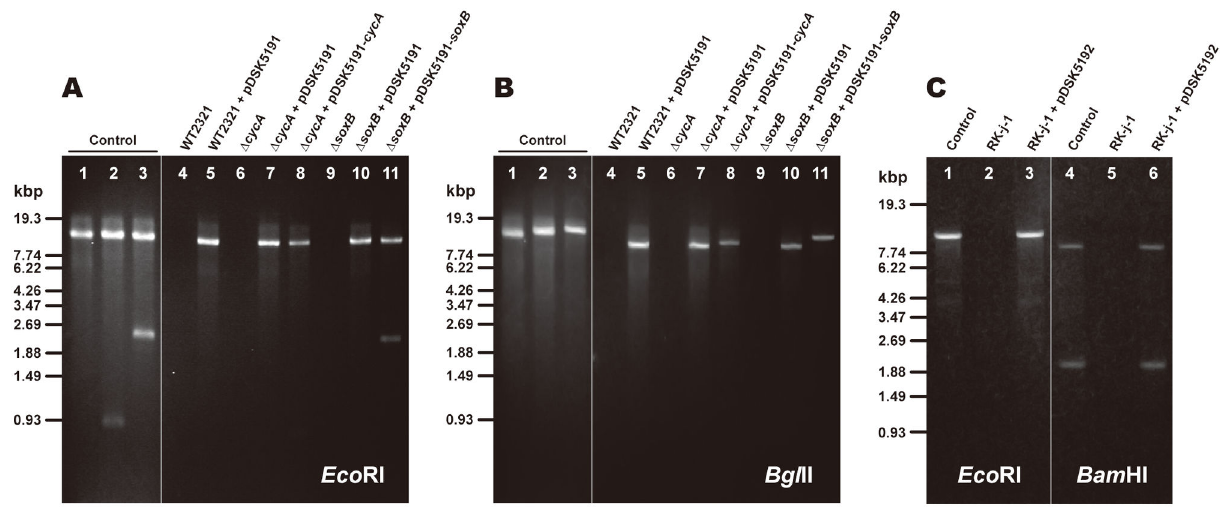
Figure 2. Restriction enzyme mappings of the plasmids in the C. tepidum and C. limnaeum transconjugants. (A, B) Physical maps of the plasmids from the C. tepidum transconjugants. The maps were constructed with restriction enzymes Eco RI (A) and Bgl II (B). The restriction fragments were separated by agarose gel (1%) electrophoresis. The control plasmids pDSK5191 (lane 1), pDSK5191- cycA (lane 2), and pDSK5191- soxB (lane 3) were obtained from the donor S17-1 cultures. Lanes 4-11 are the plasmid samples of the C. tepidum cultures. The genotype of C. tepidum is indicated above each lane. The bars and numbers at the left side of the panel indicate mobility and size of the Sty I digests of the λ-phage DNA. (C) Physical maps of the plasmids from C. limnaeum transconjugants. The maps were constructed with restriction enzymes Eco RI (lanes 1–3) and Bam HI (lanes 4–6). Lanes 1 and 4 are pDSK5192 plasmids prepared from the donor S17-1 cultures. Lanes 2-3 and 5-6 are the plasmid samples of the C. limnaeum cultures. The genotype of C. limnaeum is indicated above each lane. The bars and numbers at the left side of the panel indicate mobility and sizes of the Sty I digests of the λ-phage DNA, respectively. doi: